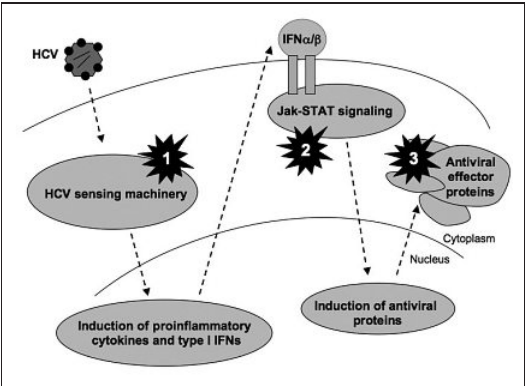
HCV interference with antiviral defence. Summary of the possible levels of HCV interference with the host